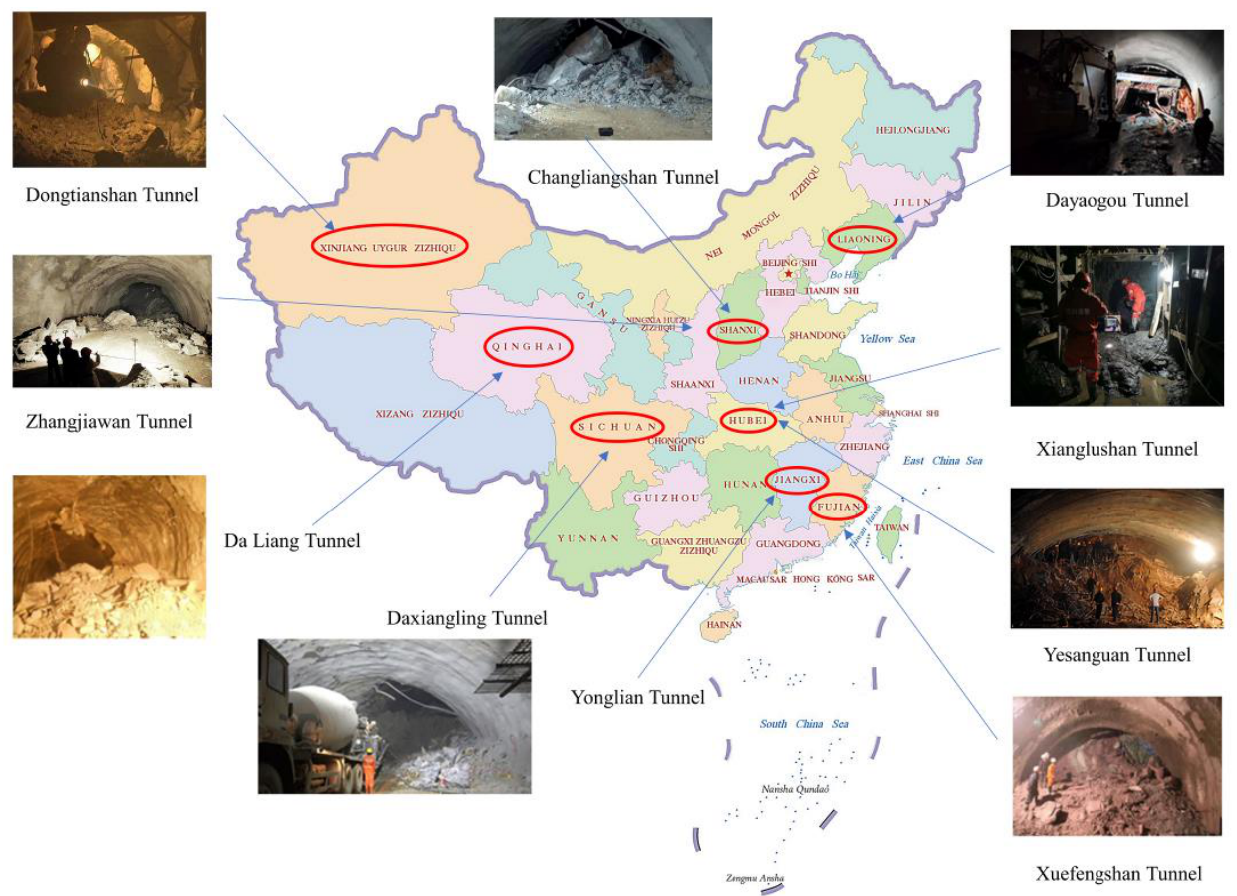
Figure 1. Survey of tunnel fault fracture zone issues.